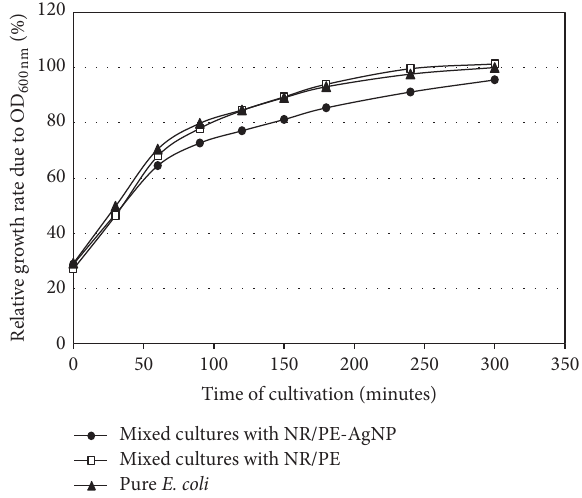
Figure 11: Influence of the NR/PE-AgNP nanocomposites on the growth rate of the E. coli liquid cultures. The data points represent the means of three cultures (standard deviation < 3%).